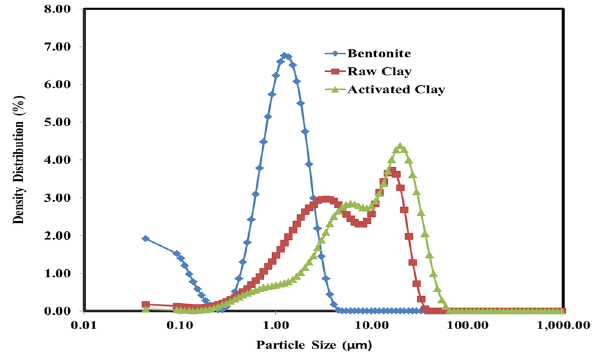
Fig. 7 Particle size distributions for the bentonite and clay (before and after the microwave treatment)